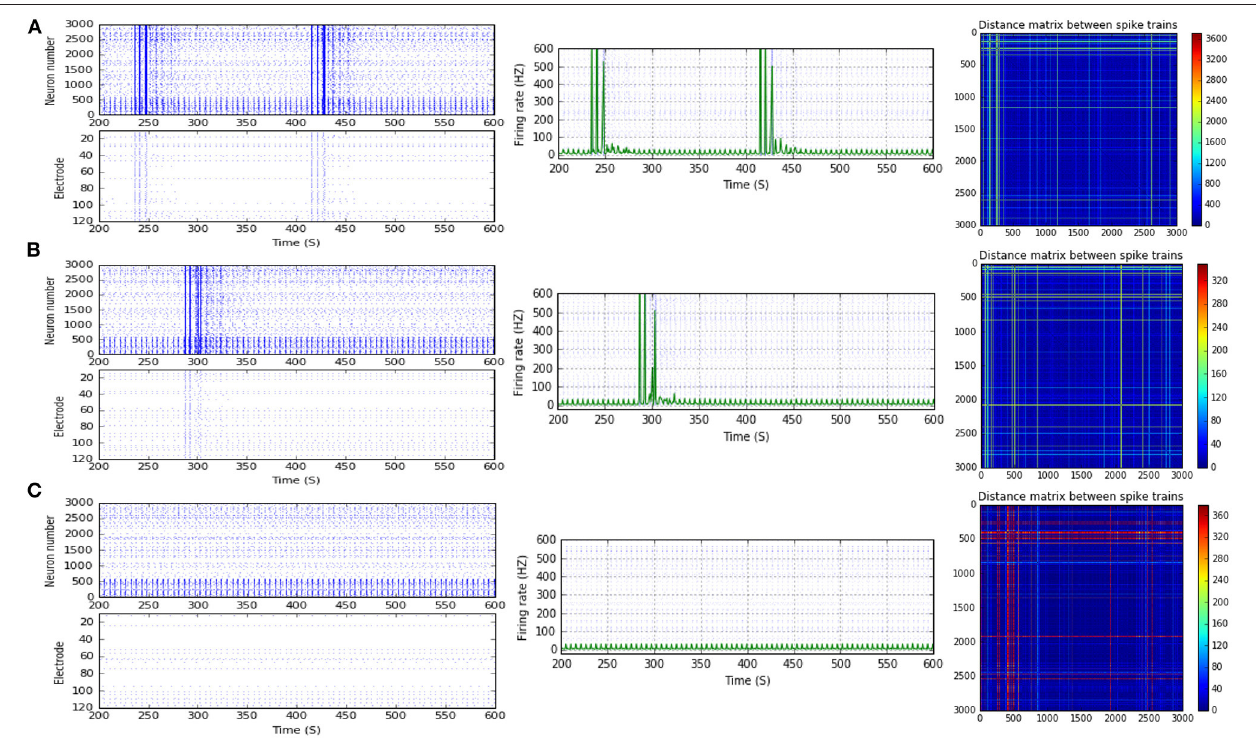
FIGURE 4 | Selected elicited firing response activity in the immature network scenario (B-2) before and after implementing STD1 and STF2 (when IF range of theta). (A) refers to the condition without implementing dynamical synapses (control) while (B,C) refer to that after implementing depressing synapses (STD1) and facilitating synapses (STF2), respectively. The first two figures of each panel refer to monitoring the pattern of firing activity in time windows from 200 to 600 seconds (s). Heat maps of each panel represent modulation changes in spike distance matrix of the network scenario (B-2) before and after implementing STD1 and STF2. The simulation time for heat maps of the spike distance is equal to